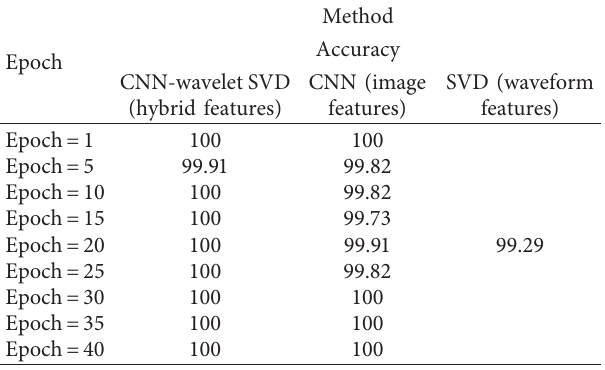
Figure 12: Recognition rate of SVM on SV features. Figure 14: Recognition rate of SVM on SV features. Table 4: Recognition rate of SVM on different features. Table 3: Recognition rate of SVM on different features.